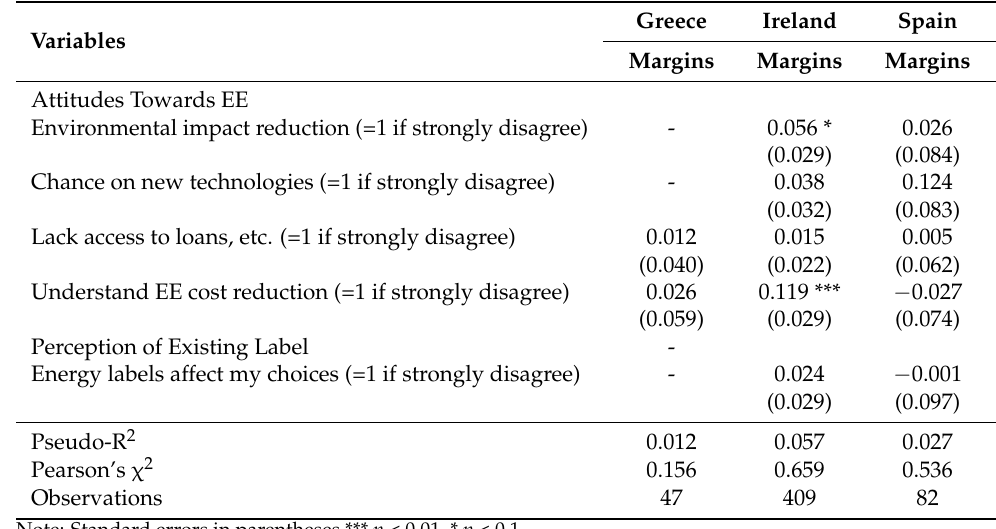
Table 11. Variables affecting firms’ perceptions of energy efficiency—probit marginal effects (country subsamples).